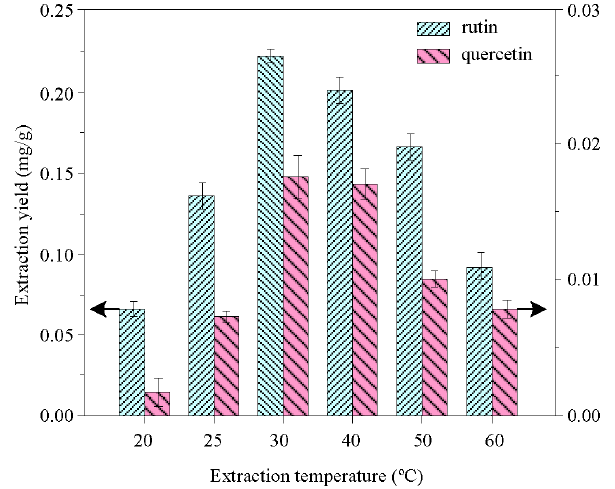
Figure 7. Effect of extraction temperature using 60% concentration of ethanol solution with 40 mL/g of ratio at 80 kHz and 200 W for 30 min on the extraction of quercetin and rutin.